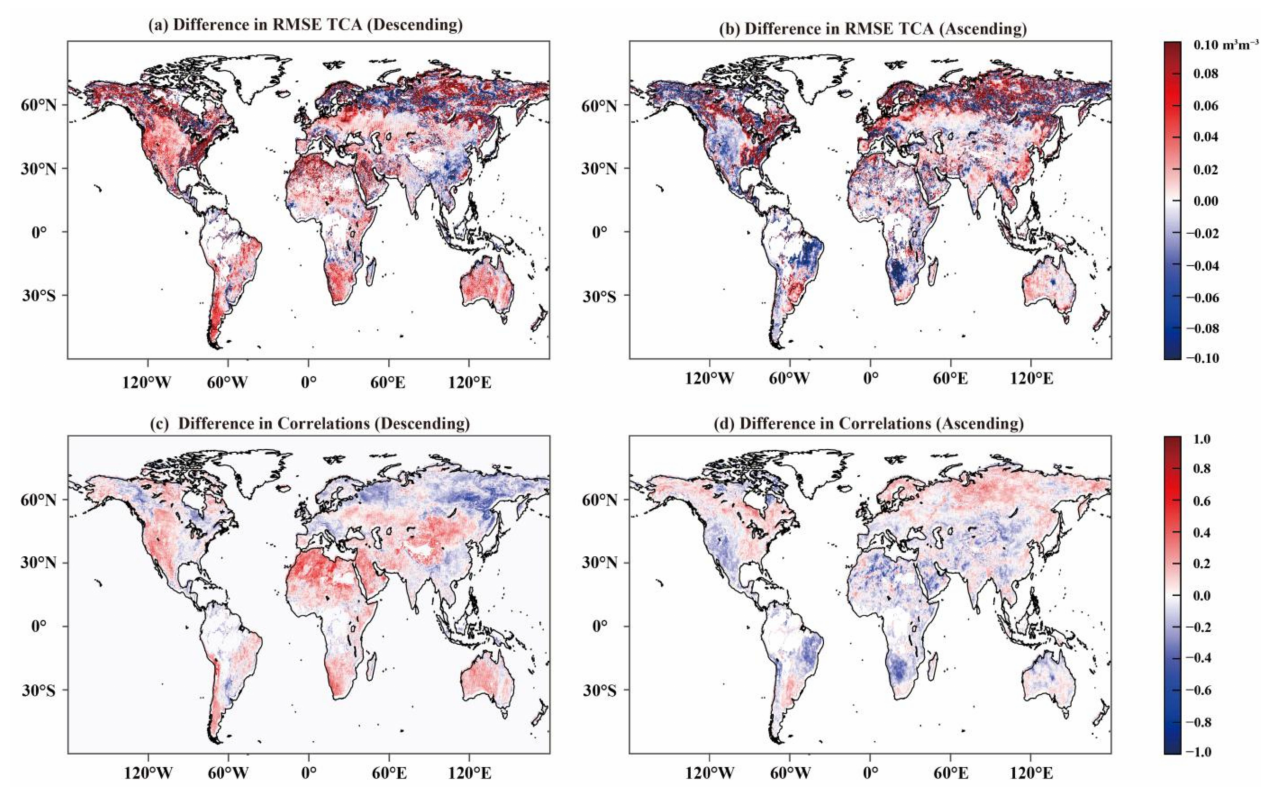
Figure 7. Global maps of the differences between the FY-3B and FY-3C SM based on ( a ) RMSE by TCA for descending data (unit: m 3 m − 3 ); ( b ) RMSE by TCA for ascending data (unit: m 3 m − 3 ); ( c ) correlation for descending data; ( d ) correlation for ascending data. Red color shows higher qualities in FY-3B, while blue color shows higher qualities in